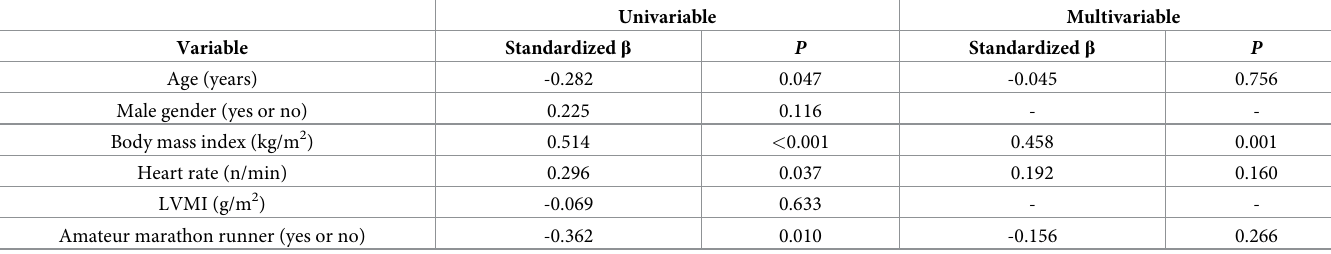
Table 3. Univariable and multivariable linear regression models for EATVI overall (n = 50).